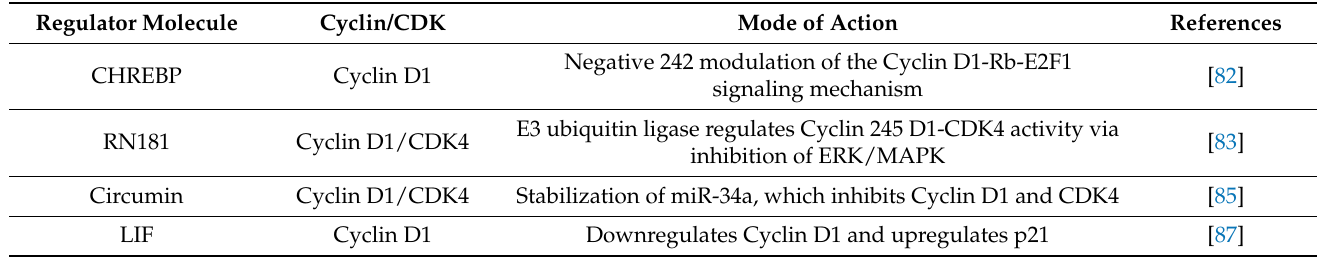
Table 1. The upstream molecules or inhibitors downregulating Cyclin D1 in gastric cancer are shown, along with their mode of